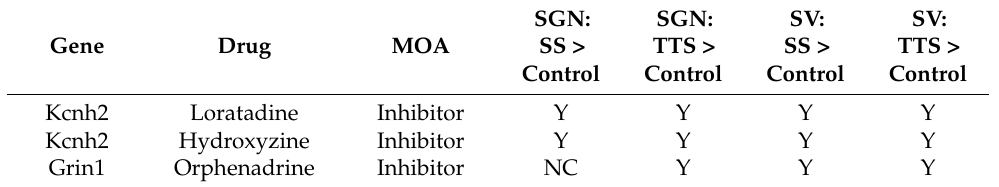
Table 9. FDA approved, orally administered antihistamines that interact with steroid-responsive genes in the cochlea localized to SGN and SV cell